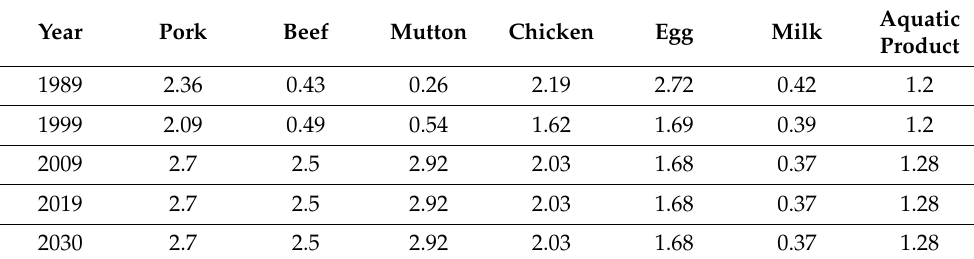
Table 1. Forage required per unit of product from 1989 to 2030.